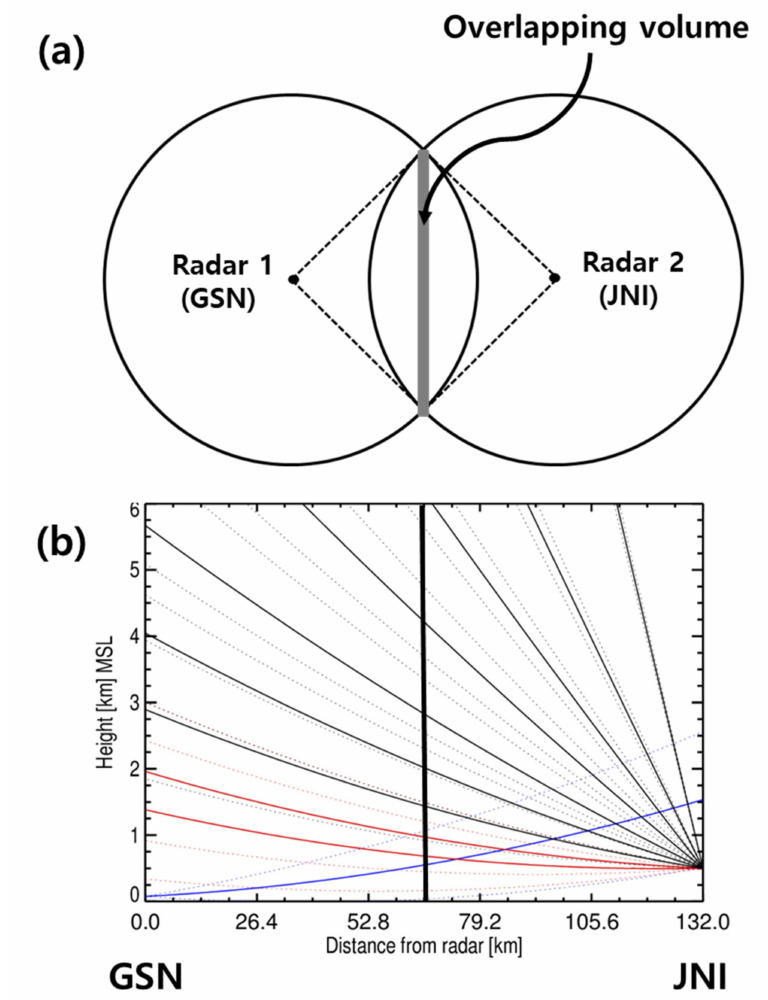
Figure 5. Example of selection of overlapping volume of the two radars. ( a ) Overlapping volume at equidistance between adjacent radars. The black dashed line indicates the range of azimuth angles including equidistance line. ( b ) Example for the selection of overlapping volumes between adjacent radars (GSN and JNI radar). The solid vertical line indicates the range at the center of equidistance. The solid (dotted) lines indicate the height at center (top and bottom) of the radar beams. The top and bottom of the radar beams are defined by considering the beam width. The red lines represent the matched elevation angles relative to blue